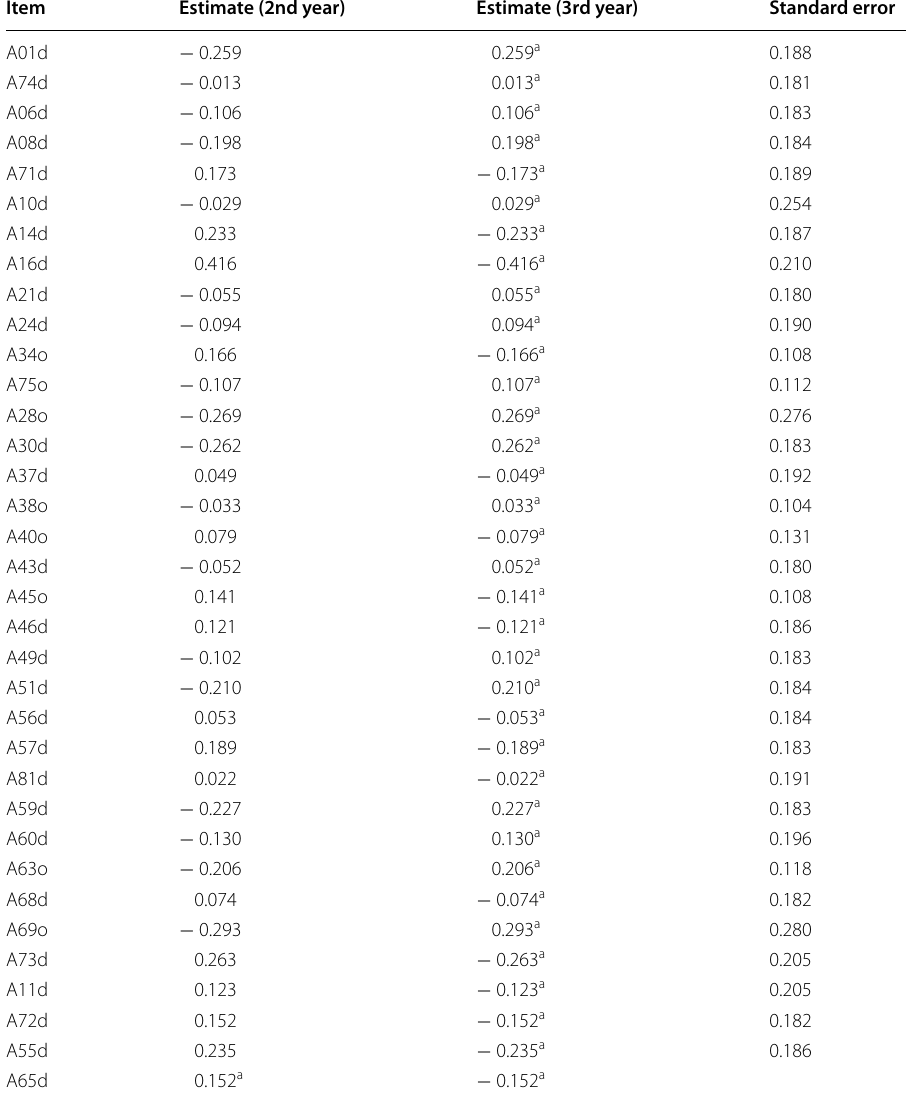
Table 17 DIF item analysis to identify subgroup invariance between years of nursing education at the item level for measurement in the third